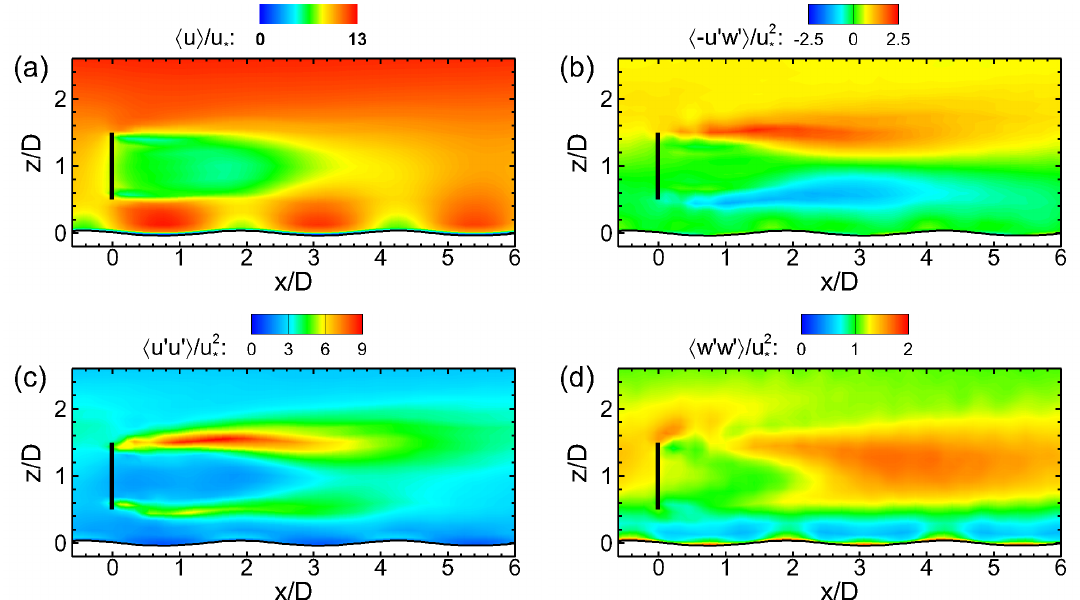
Figure 3. Statistics of turbulent wind flows for the fixed-turbine case. Statistics were obtained using the swell-phase average approach. Statistics for Phase 2 (when the forward slope of the swell reaches the turbine) are plotted: ( a ) streamwise velocity (cid:104) u (cid:105) ; ( b ) Reynolds stress (cid:104)− u (cid:48) w (cid:48) (cid:105) ; ( c ) streamwise velocity variance (cid:104) u (cid:48) u (cid:48) (cid:105) ; and ( d ) vertical velocity variance (cid:104) w (cid:48) w (cid:48) (cid:105) . Statistical quantities were normalized using wind-friction velocity u ∗ . The location of the turbine-rotor disk is indicated by the thick black